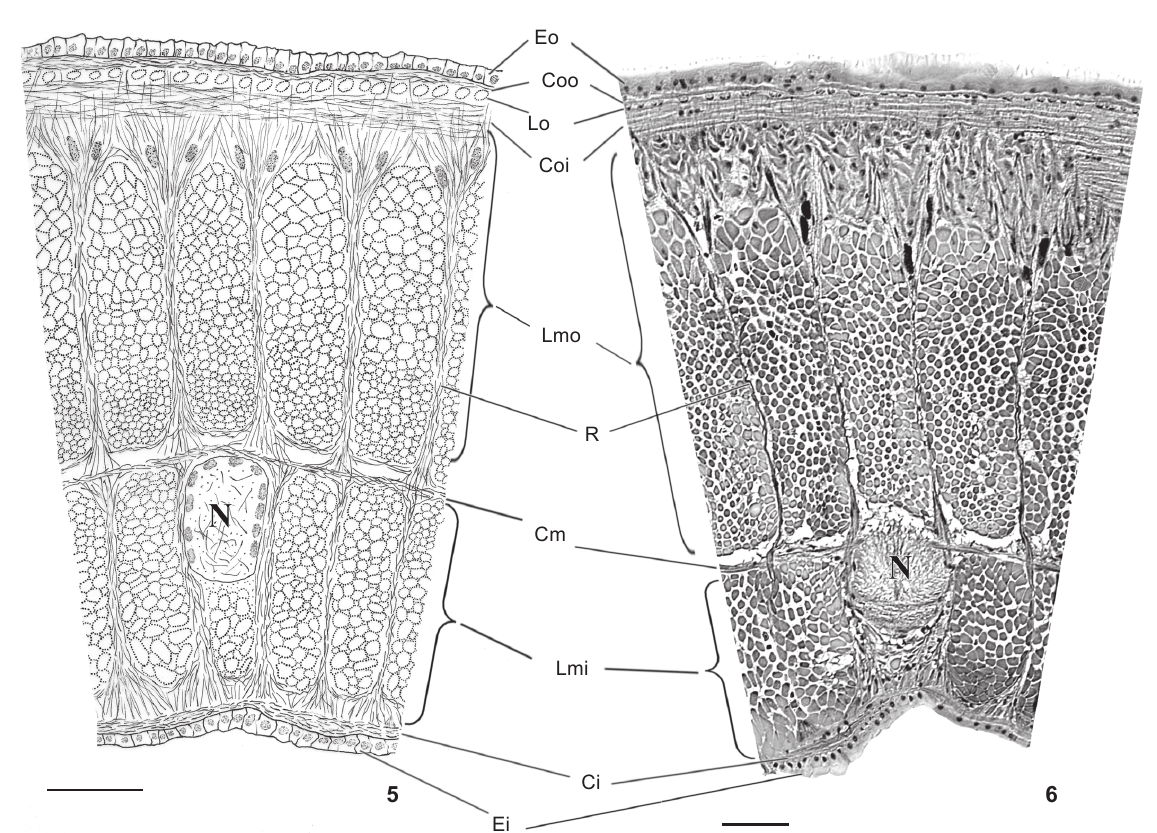
Figures 5-6. Tellina lineata . Diagrammatic representation (5) of the cross section (6) of the inhalant siphon. (Ci) Inner circular layer, (Cm) median circular layer, (Coi and Coo) inner and outer parts of the outer circular layer, (Ei) inner epithelium, (Eo) outer epithelium, (Lmi and Lmo) inner and outer parts of the median longitudinal layer, (Lo) outer longitudinal layer, (N) nerve cord, (R) radial fibers. Scale bars: 10 µm.